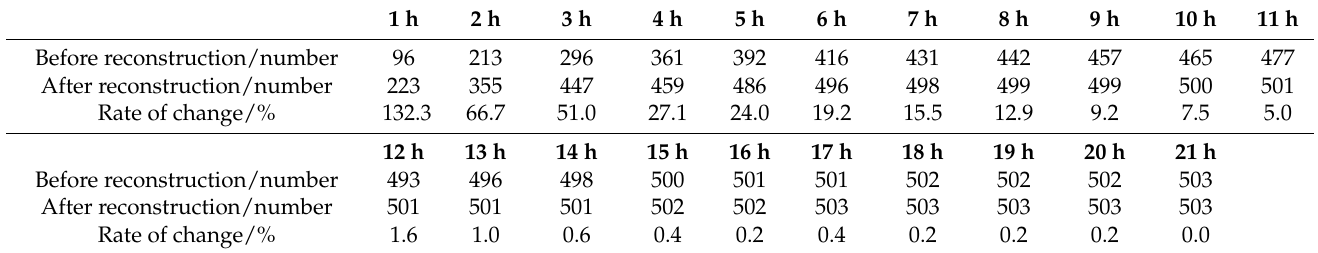
Table 9. Resident number within different accessibility ranges before and after